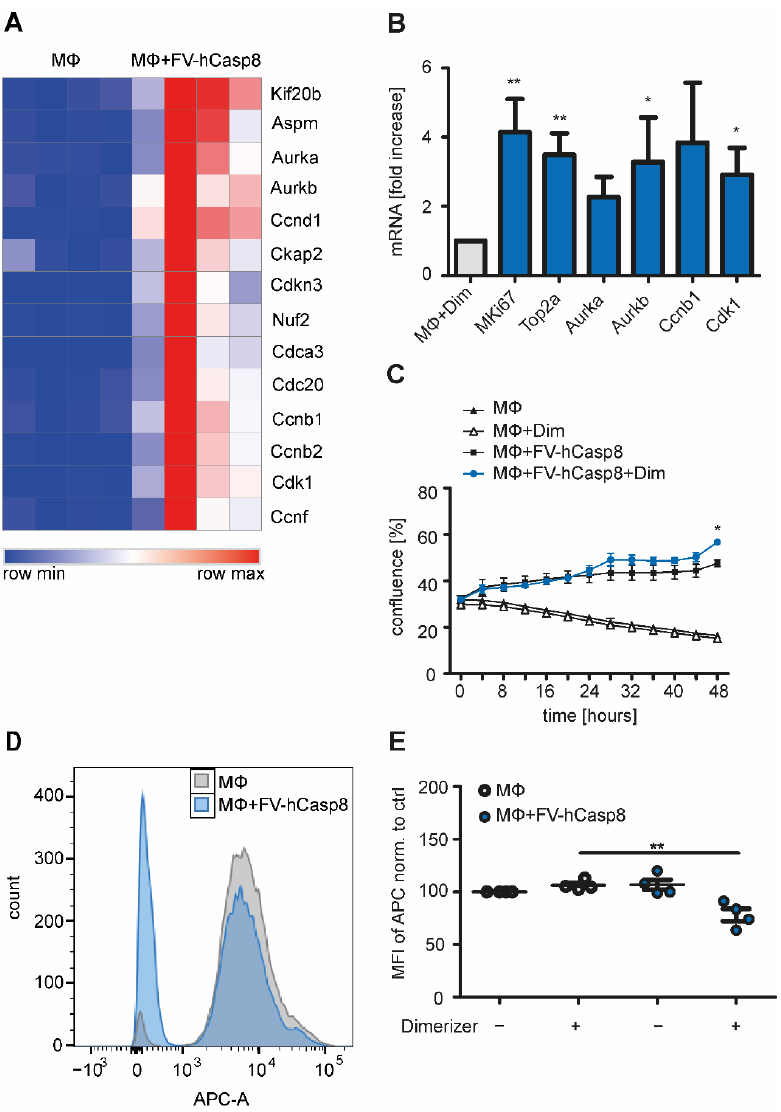
Figure 5. Peritoneal macrophages are proliferating in vitro after co-culture with apoptotic cells . ( A ) Heat map shows regulation of 14 genes associated with activation of cell cycle. ( B ) Macrophages (M Φ ) were co-cultured with or without apoptotic cells and mRNA levels of cell cycle genes were quantified. Fold increase to control (MΦ+Dimerizer) normalized to RPLP0 is shown ( n = 4, 5). ( C ) Confluence of peritoneal macrophages co-cultured with apoptotic cells was determined over 48 h ( n = 3). ( D ) IC-21 cell were stained with eFluor 670 and co-cultured with apoptotic cells for 24 h. The histogram shows the eFluor 670 (APC) fluorescence of IC-21 cells co-cultured with living or apoptotic NIH 3T3 cells. ( E ) The mean fluorescence intensity of eFluor 670 (APC) of IC-21 cells co-cultured with living or apoptotic NIH 3T3 cells was measured ( n = 4). Mean ± SEM are shown. * p < 0.05; ** p < 0.01.